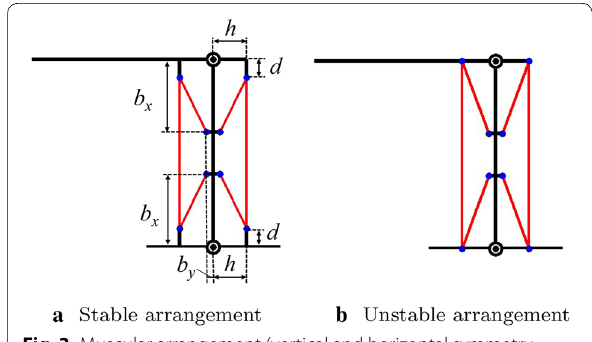
Fig. 3 Muscular arrangement (vertical and horizontal symmetry, 310, L 2 270, h 50, b x 120, b y 10, d 30 or 0 [mm]) L 1 = = = = = =